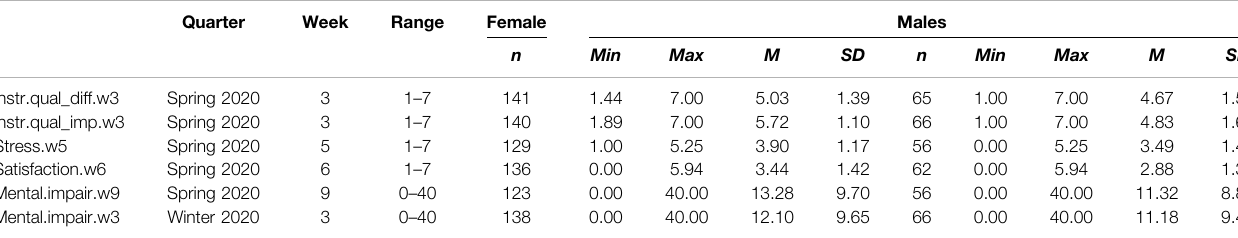
TABLE 1 | Descriptive statistics of all scales.